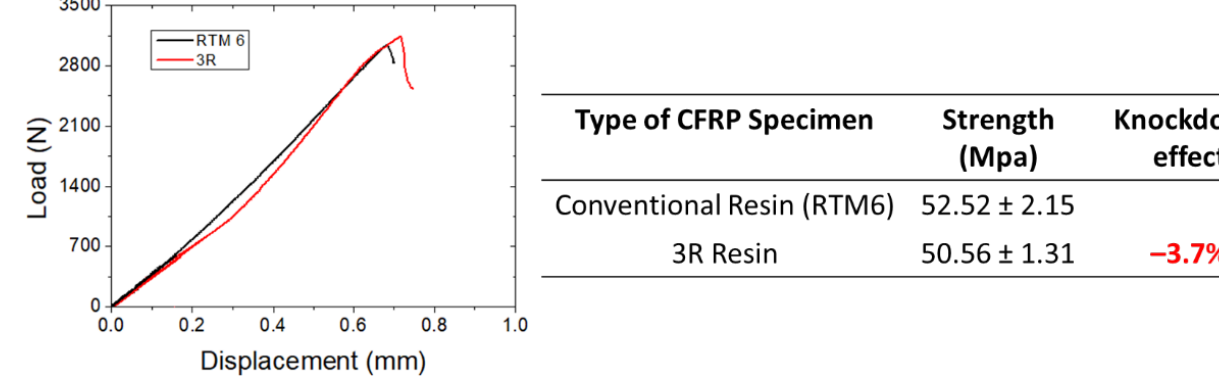
Figure 4. Representative plots of ILSS specimens ( left ) and knockdown effect for maximum strength ( right ).